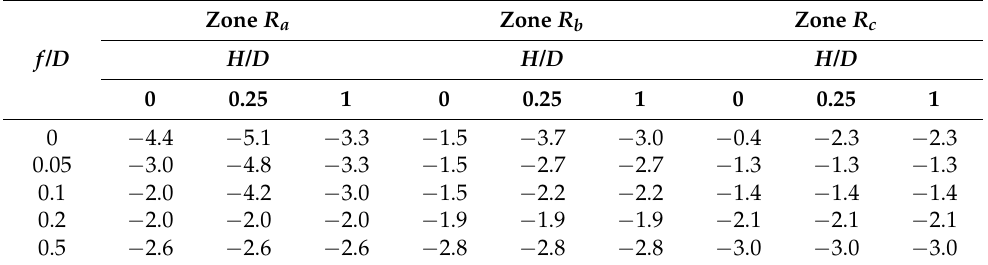
Table 4. Negative peak pressure coefficients for cladding design prescribed in AIJ-RLB (2015) [22].